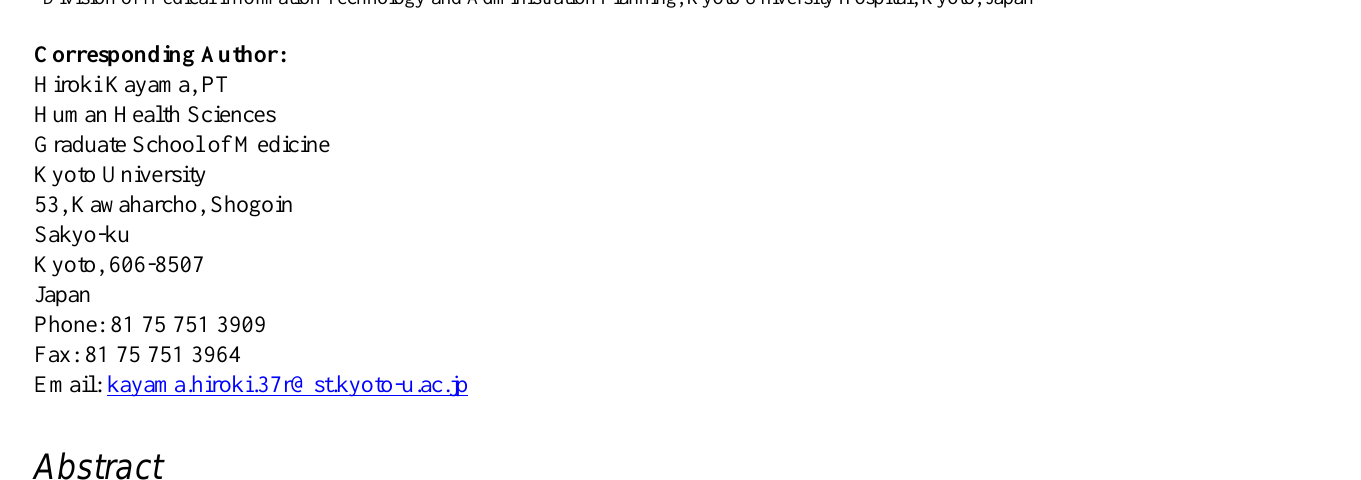
fall prevention; cognitive function; dual-task; training;